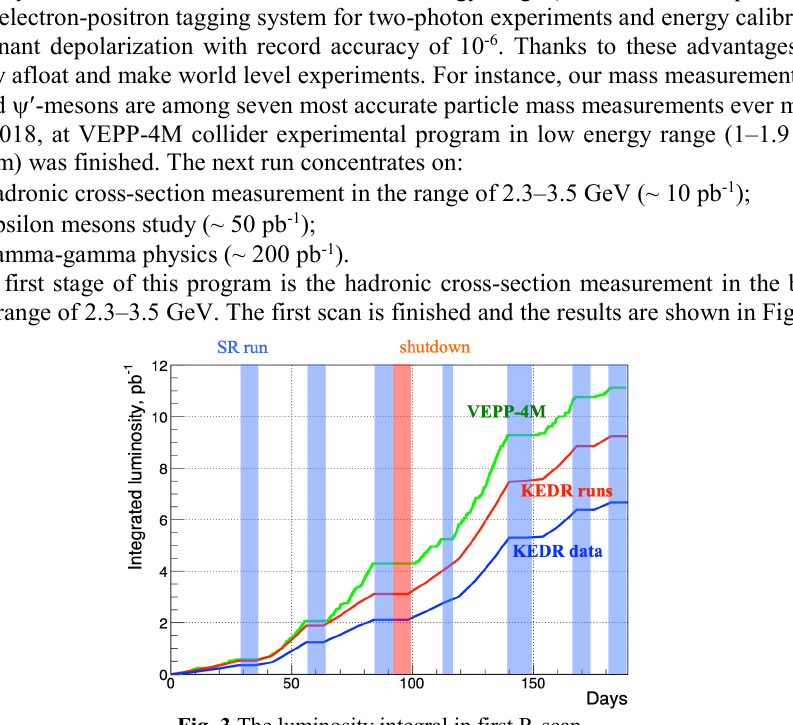
Fig. 3 The luminosity integral in first